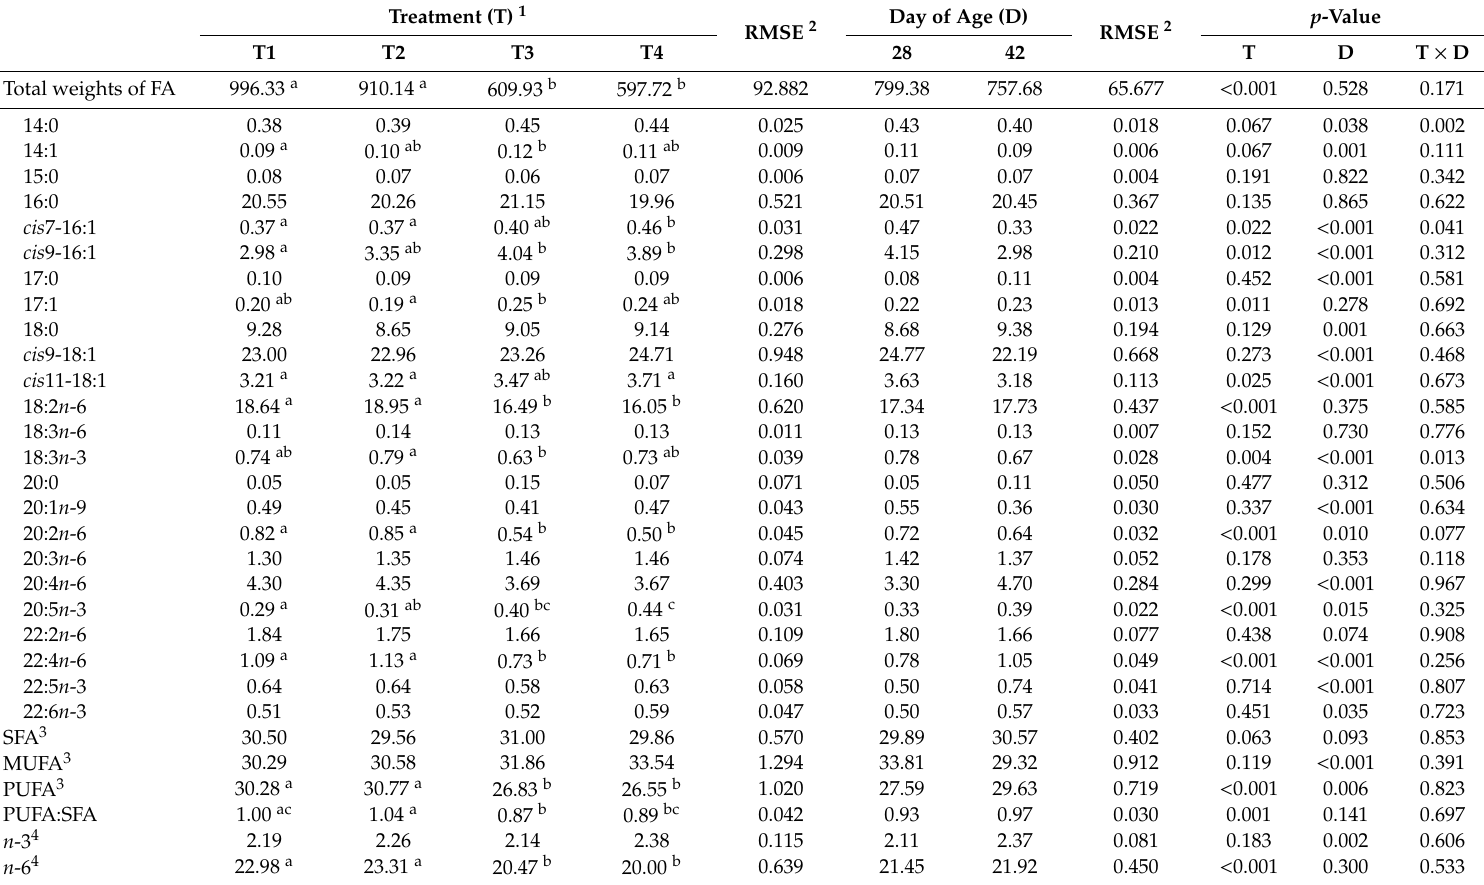
Table 3. E ff ects of treatment and age on the total weights of fatty acids (mg / 100g wet tissue) and the fatty-acid (FA) profile (% of total FAs) of breast meat (adjusted for total weights of